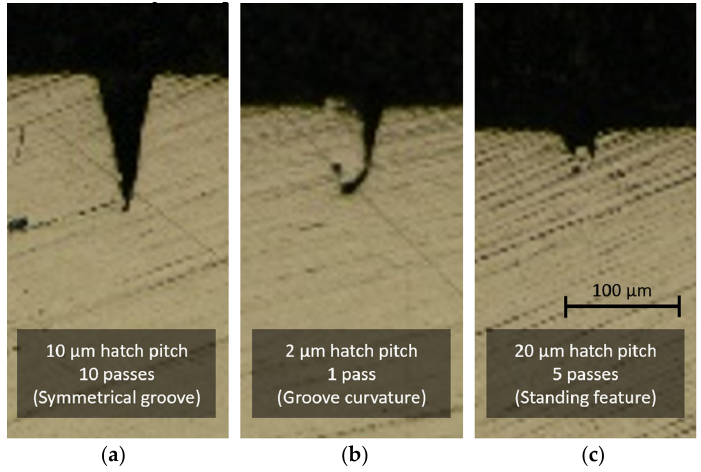
Figure 8. Cross ‐ sectional profiles of ( a ) a regular groove with a hatch pitch of 10 μ m and 10 passes, ( b ) an anomaly due to wall collapsing with a hatch pitch of 2 μ m and 1 pass, and ( c ) an anomaly due to an overly large hatch pitch of 20 μ m and 5 passes. All grooves are made with the bidirectional scanning strategy.